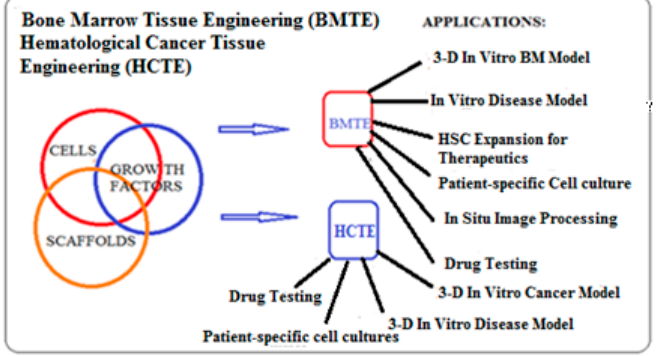
Figure 2. Triadic interaction of cells, growth factors, and scaffolds in BMTE and HCTE.